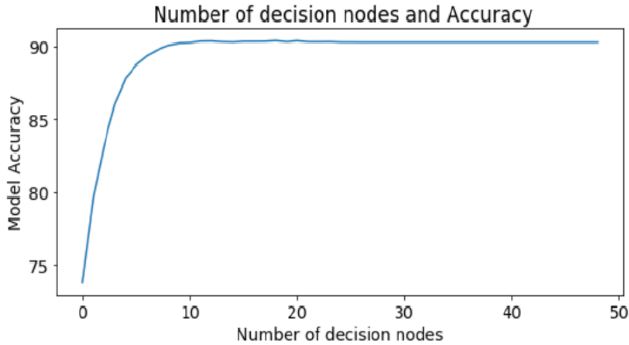
Figure 7. Number of nodes vs. test accuracy of the random forest algorithm.